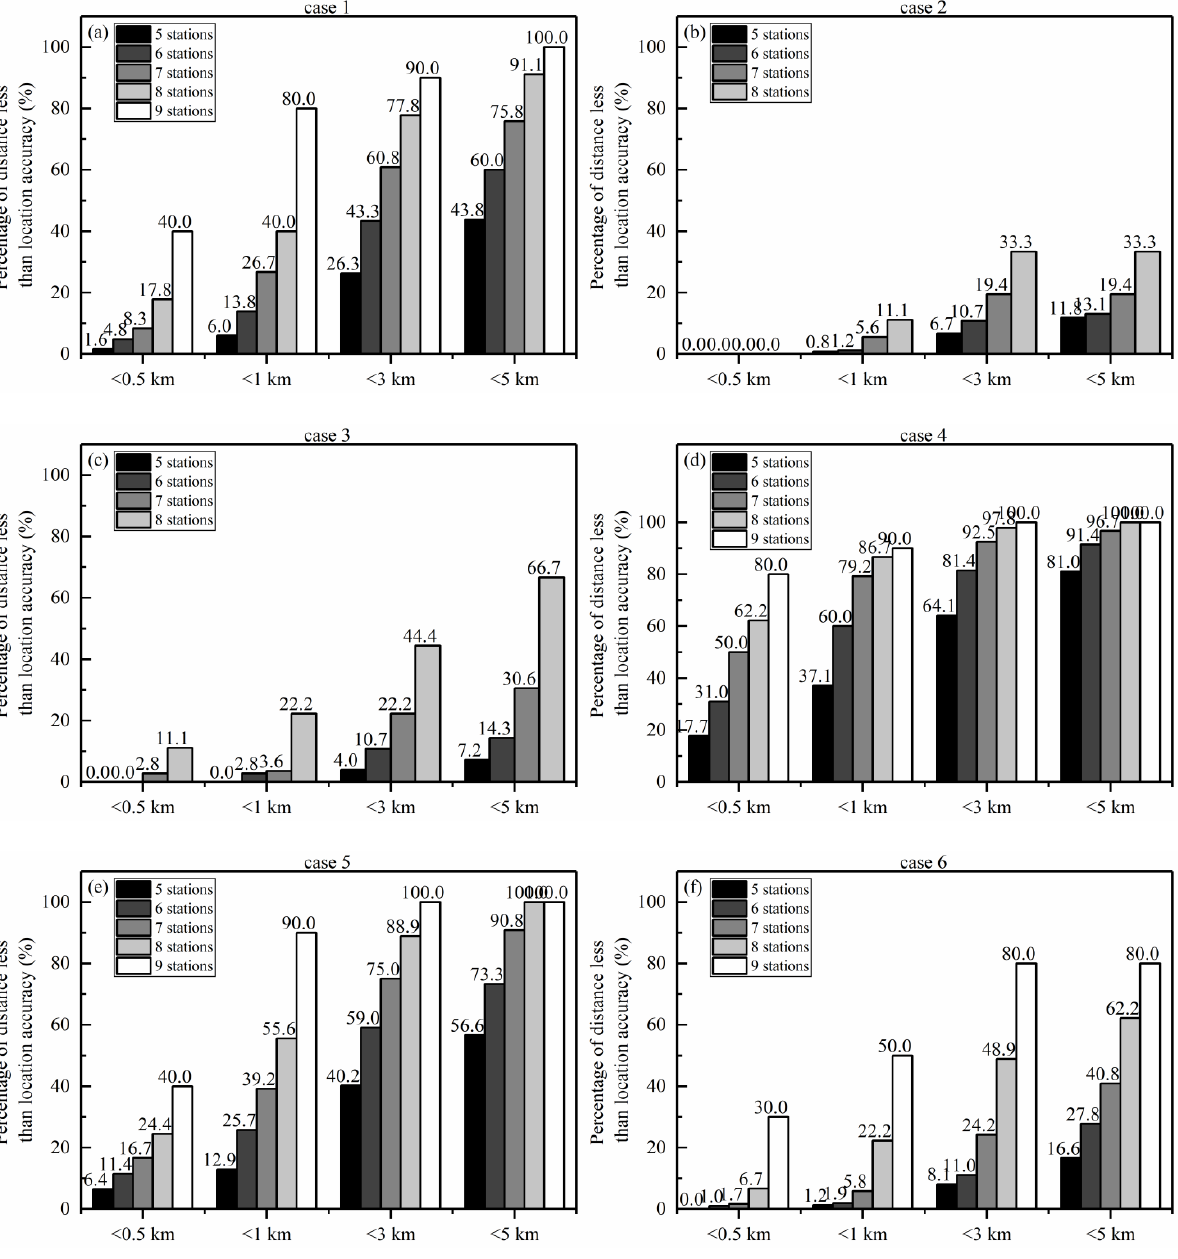
Figure 10. The percentage of deviation distance less than the specific location accuracy for six cases with different number of participating stations. ( a – f ) correspond to the results of case 1 to case 6. In this paper, we established a regional lightning detection and location network in Fujian, China. Magnetic field antennas and fast electric field antennas working in VLF/LF band are equipped, and six cases detected by the network in 2021 summer from different directions are chosen to research the effect of number and configuration of participating stations on the quality of the lightning location outside the network. The ToA technique is used to determine the lightning location. The reference location is validated by the tight intersection region consisting of all hyperbolas and by the close correlation with the low cloud top temperature region. The deviation distance between the reference location and the locations for different number and configuration of stations decrease with the increase of number of participating stations and increase with the distance away from the network.